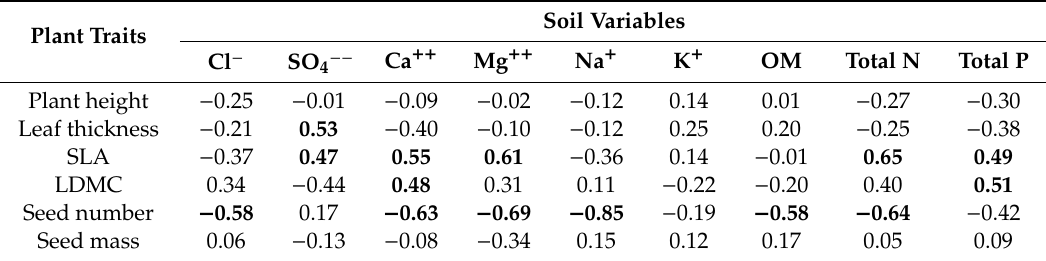
Table 1. Simple linear correlation coe ffi cient ( r ) between the soil variables and functional traits of Onopordum alexandrinum . SLA: Specific Leaf Area; LDMC: Leaf Dry Matter Content. Bold values indicate significant at p <